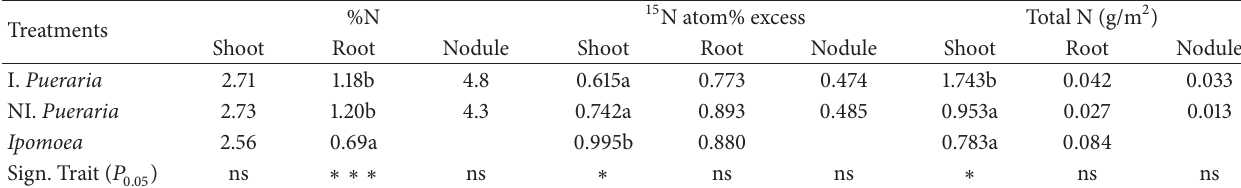
Table 3: Effect of bradyrhizobial inoculation on plant N status after 4-month growth. Treatments